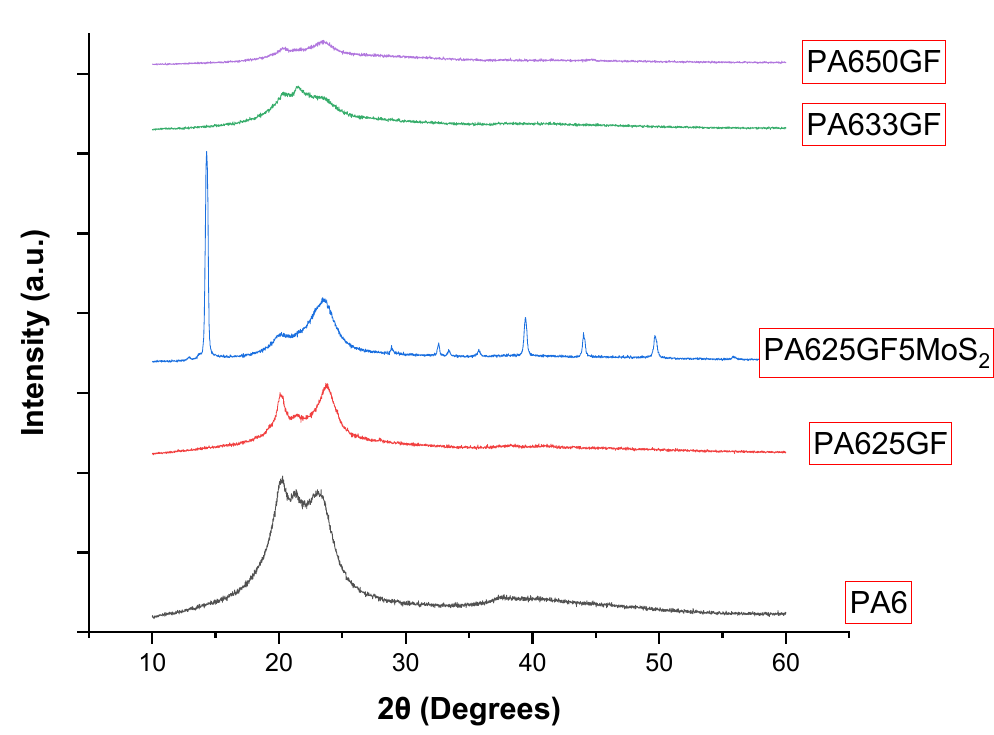
Figure 12. XRD patterns of PA6 and PA6 composite materials. Table 6. Degree of crystallinity of PA6 and PA6